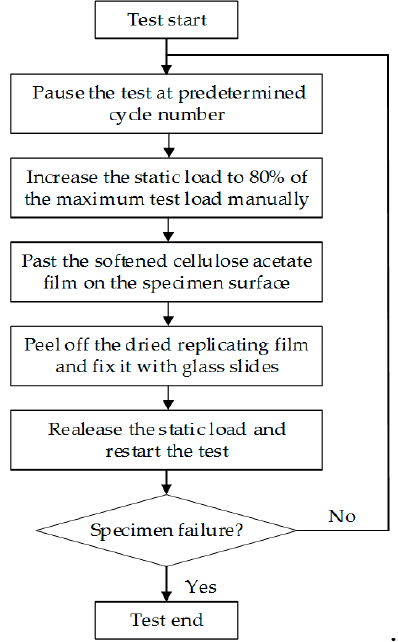
Figure 3. The operation steps of the replica test.